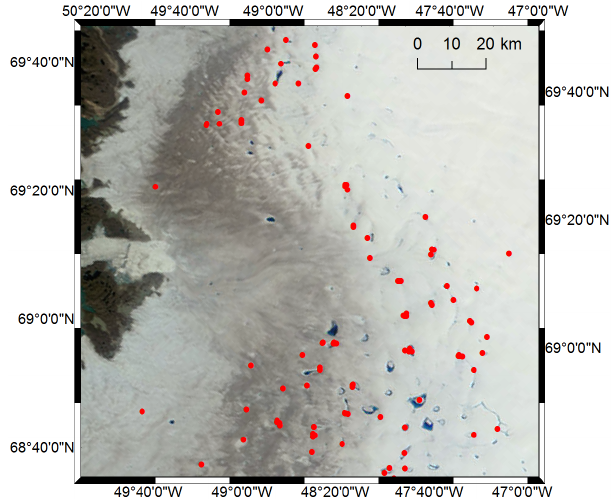
Figure 3. Radar-detected buried lake locations (red dots) over- lain on MODIS Rapid Response image from 7 August 2010. Note clear correspondence of radar-detected lake locations with many supraglacial lakes clearly visible in this image; all the buried lakes in the data set were associated with visible supraglacial lakes cap- tured in at least one MODIS image over the analysis period.